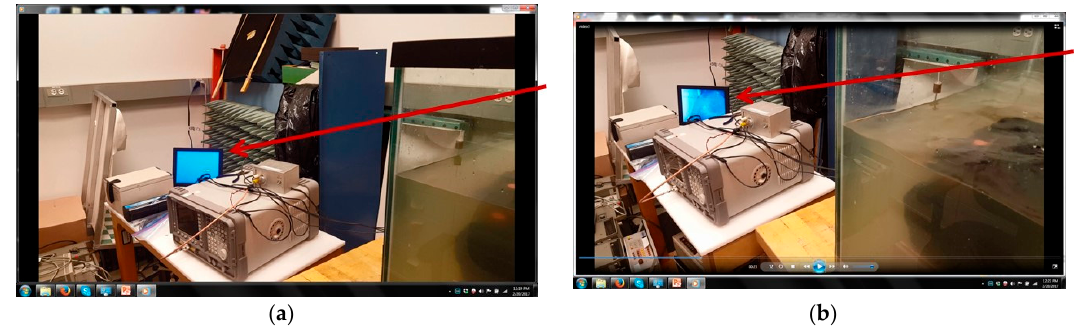
Figure 7. ( a ) The Wi-Fi underwater video transmitter is moved beyond the free space communication range in a seawater aquarium with still water surface; ( b ) The video link is re-established when the seawater surface is agitated.